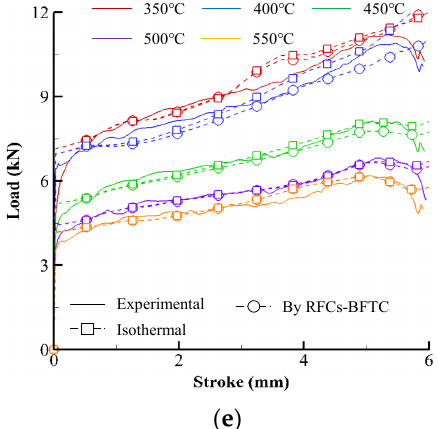
Figure 2. Experimental CLSCs and their predictions by the RFCs–BFTCs in Figure 3: ( a ) 0.1 s − 1 , ( b ) 1 s − 1 , ( c ) 5 s − 1 , ( d ) 10 s − 1 , and ( e ) 20 s − 1 .